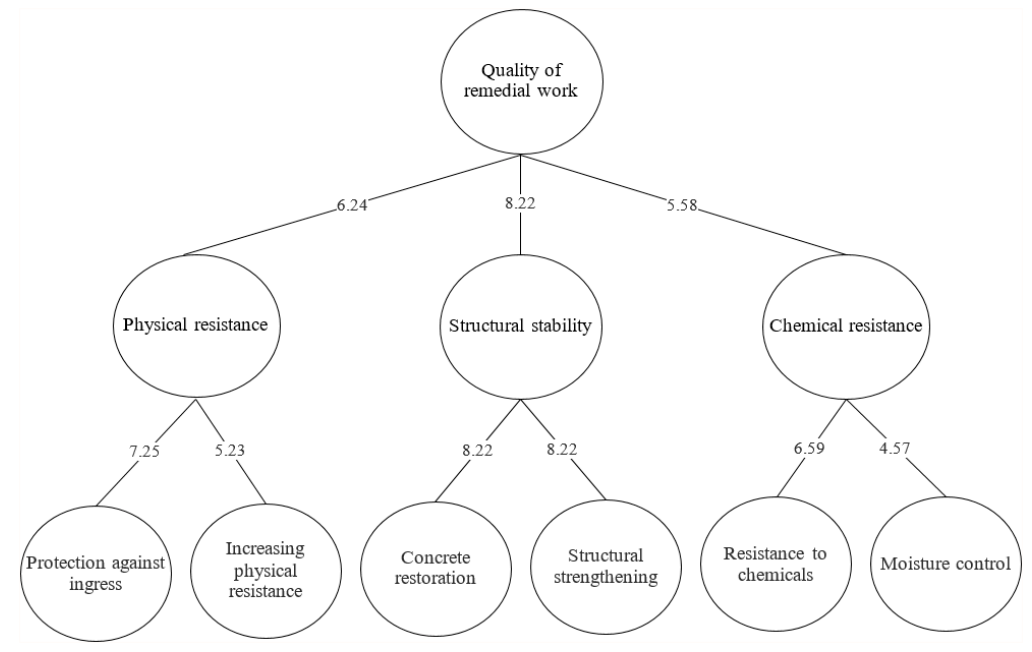
Figure 8. Overall framework for remedial treatment.